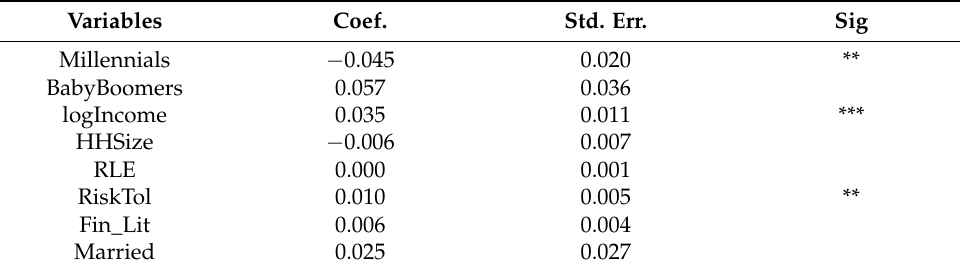
Table A5. Retirement Preparedness Estimation for Simulated 60–40